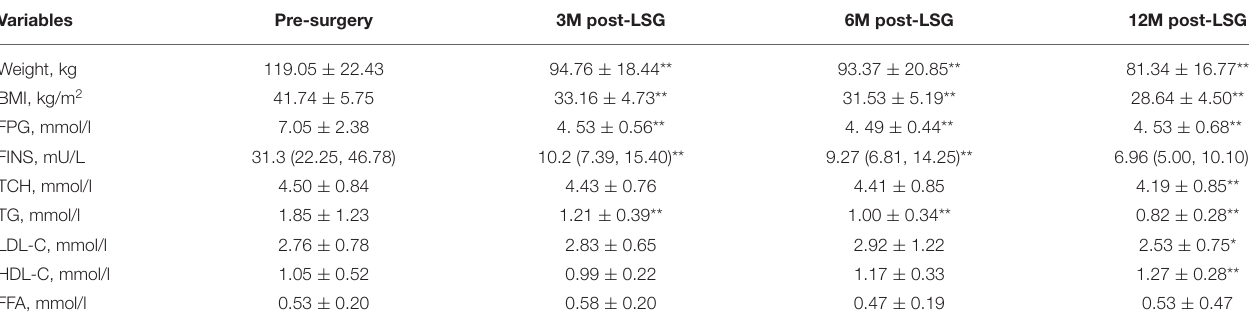
TABLE 4 | Change in metabolic marker follow up 3, 6 month and 12 months post-operation.